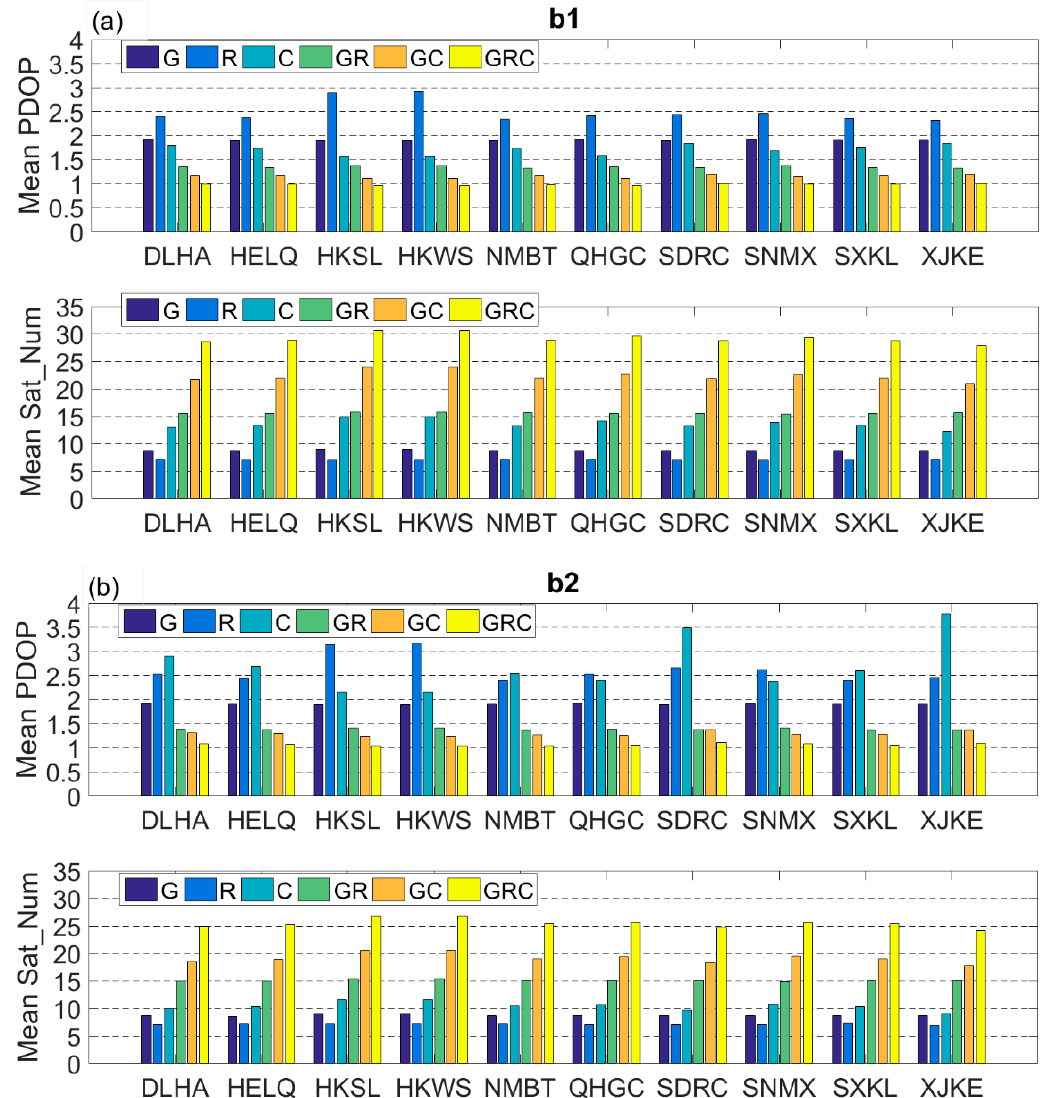
Figure 4. Mean number of satellites and mean PDOP for different SF-SPP processing scenarios at 10 selected stations on 5 February 2019, ( a ) b1 SPP; ( b ) b2 SPP; the abbreviation G, R and C represent GPS, GLONASS and BDS, respectively.